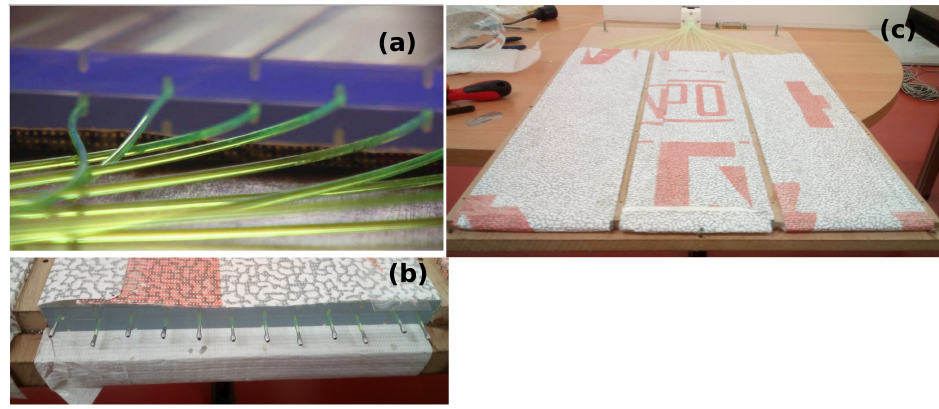
Figure 3. ( a ): Close up of the WLS fibers placed along the scintillation tile’s grooves. ( b ): Reflective paint is applied to the WLS fibers on their free end. ( c ): The scintillation tiles with the WLS fibers are wrapped inside reflective Tyvek paper.